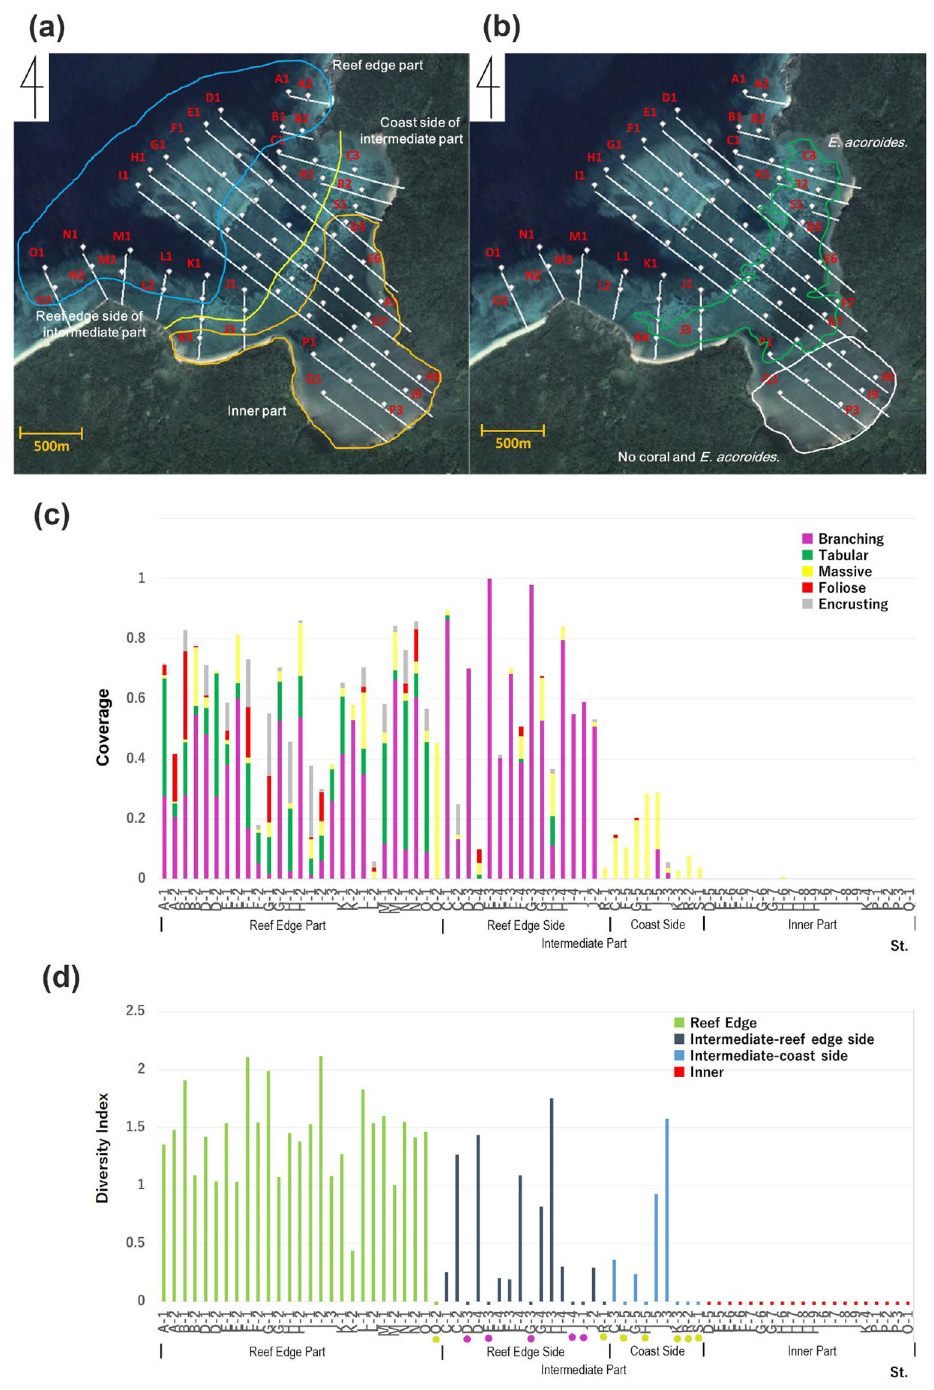
Fig. 2 a Classification of parts in Sakiyama Bay. The reef edge part is surrounded by a blue line. The inner part is surrounded by an orange line. The intermediate parts are between them. The reef edge and coast sides are divided by a yellow line. b Distribution region of E. acoroides. E. acoroides is distributed in the region surrounded by a green line. No coral and E. acoroides are distributed in the region surrounded by a white line. c Coral coverage classified by coral life forms. d Diversity index of corals. The zero values of the diversity index in the bay’s intermediate part show the existence of only one type of coral (branching or massive). The pink and yellow circles under the station numbers show branching and massive corals, respectively. The zero values of the diversity index in the bay’s inner part show no coral, except for St. H-6, where small massive corals exist (see c